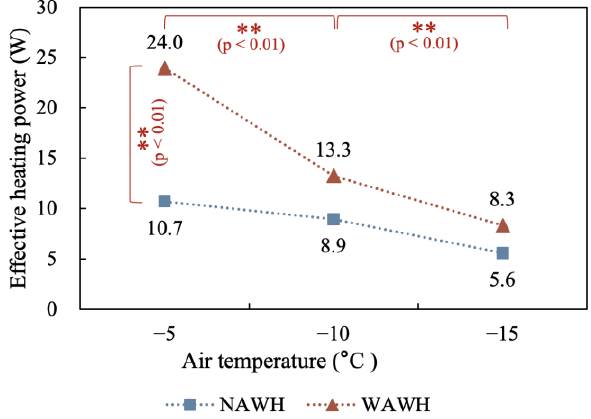
Figure 7. P eff of EHGs at different T a . Table 6. η of EHGs at different T a.